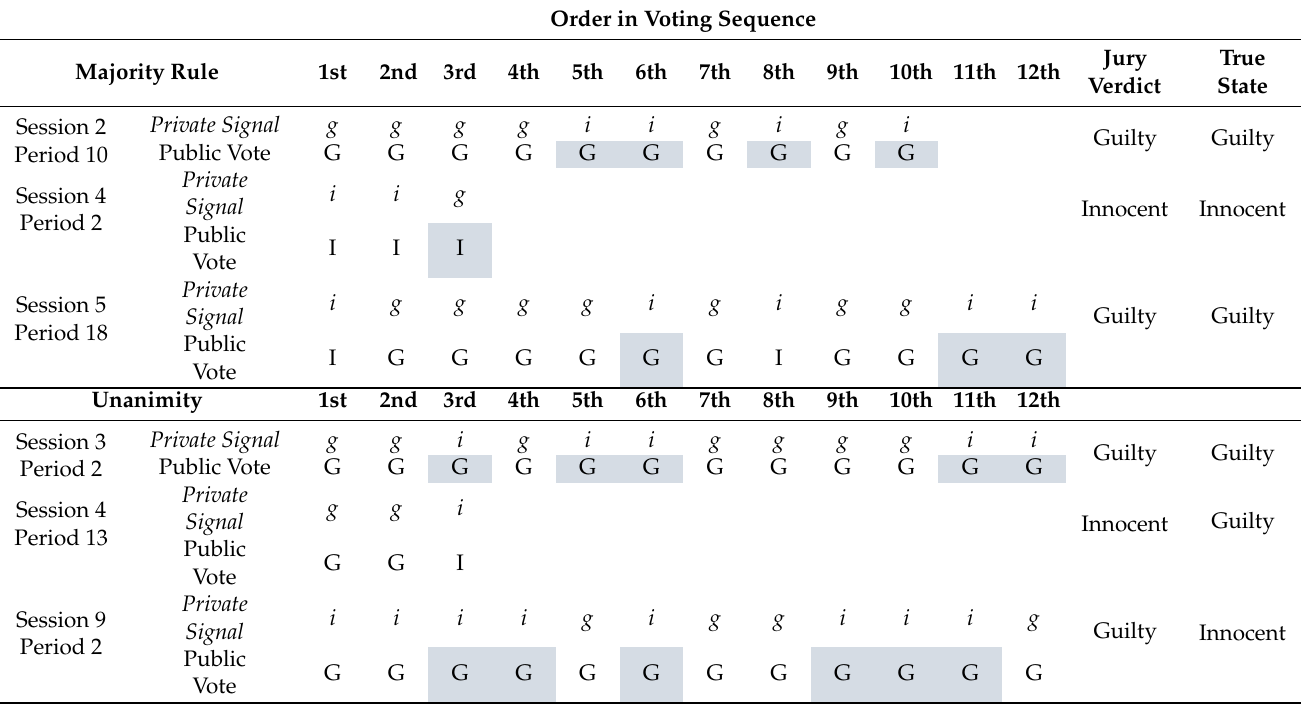
Table 3. Selected periods with sequential